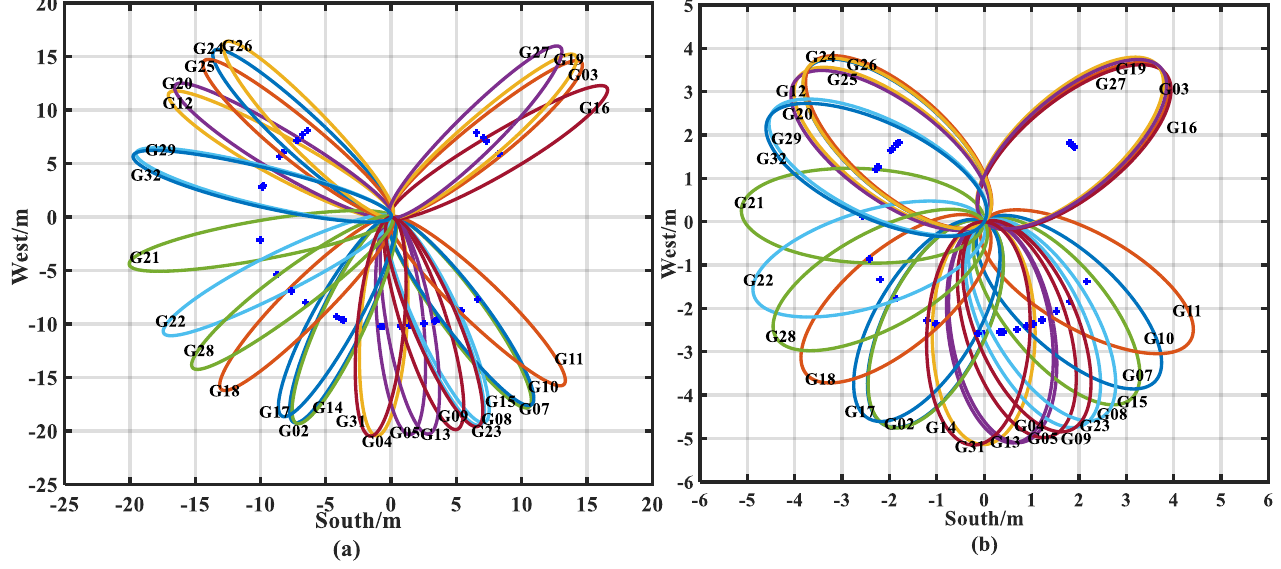
Figure 11. First Fresnel reflection region map of station P041 (DOY: 2014-065): GPS satellite distribution in the first Fresnel reflection region of station P041 when satellite elevation angle was ( a ) 10°; ( b ) 25°.